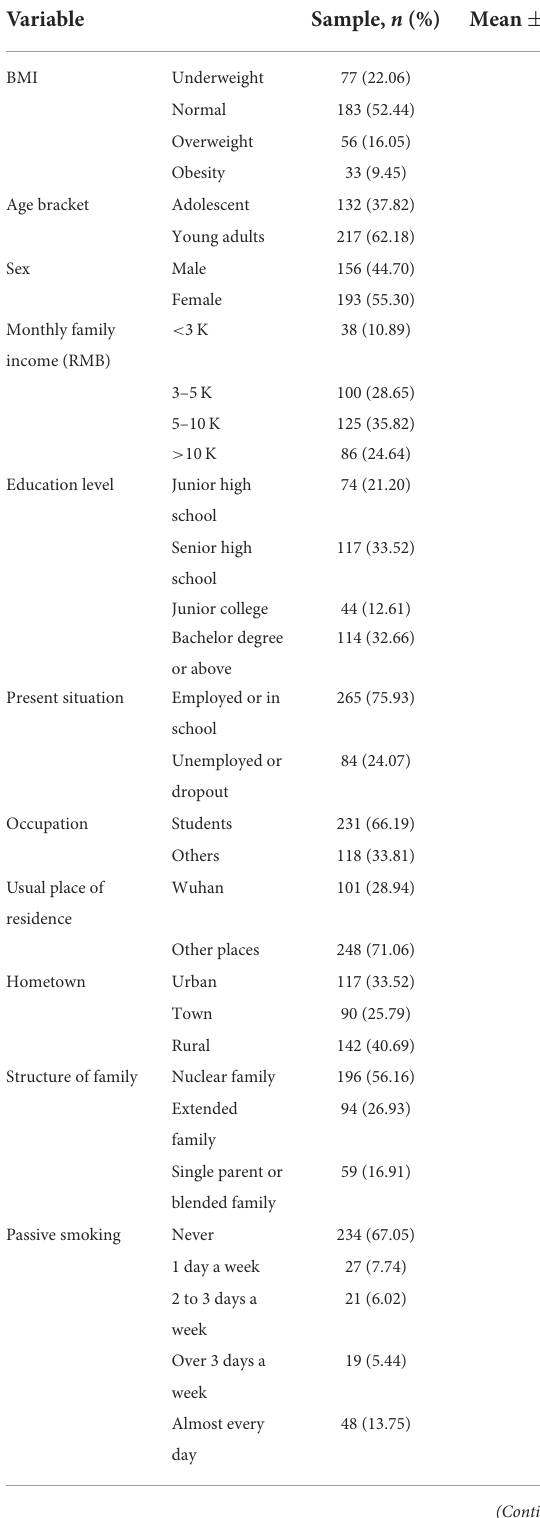
TABLE 1 Socio-demographics, pandemic-related factors, obsessive compulsive disorder (OCD) symptoms, sleep quality, and phone dependence of